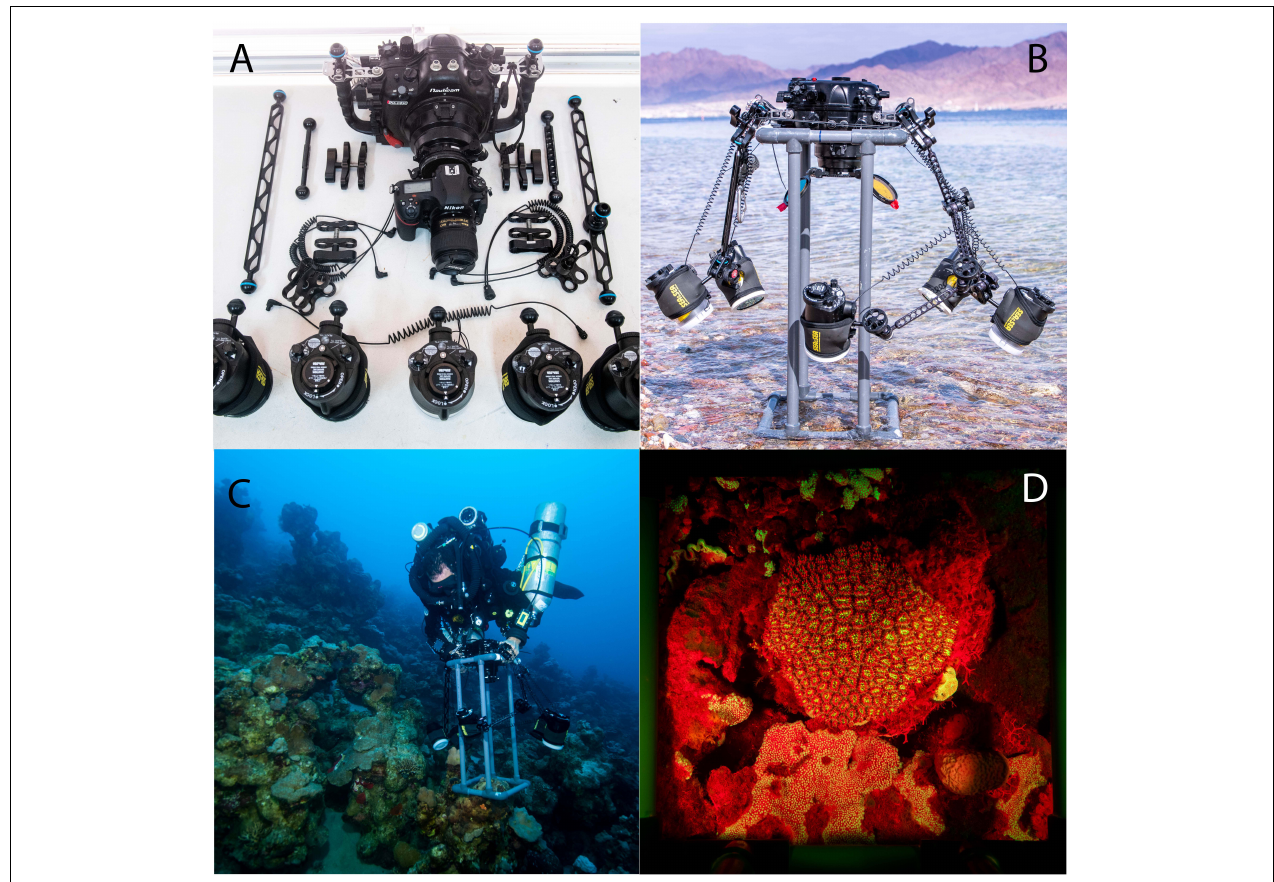
FIGURE 1 | (A) Complete gear set of Nauticam housing, Nikon D850 camera with 35 mm lens, strobes and arms before assembly. (B) The complete set assembled on the quadrat before diving. (C) A diver equipped with closed circuit rebreather and the speed-FlorIS at 45 m in Bermuda. (D) An example of stony coral’s image taken in Bermuda at daytime at 45 m with the fluorescence excitation strobe without